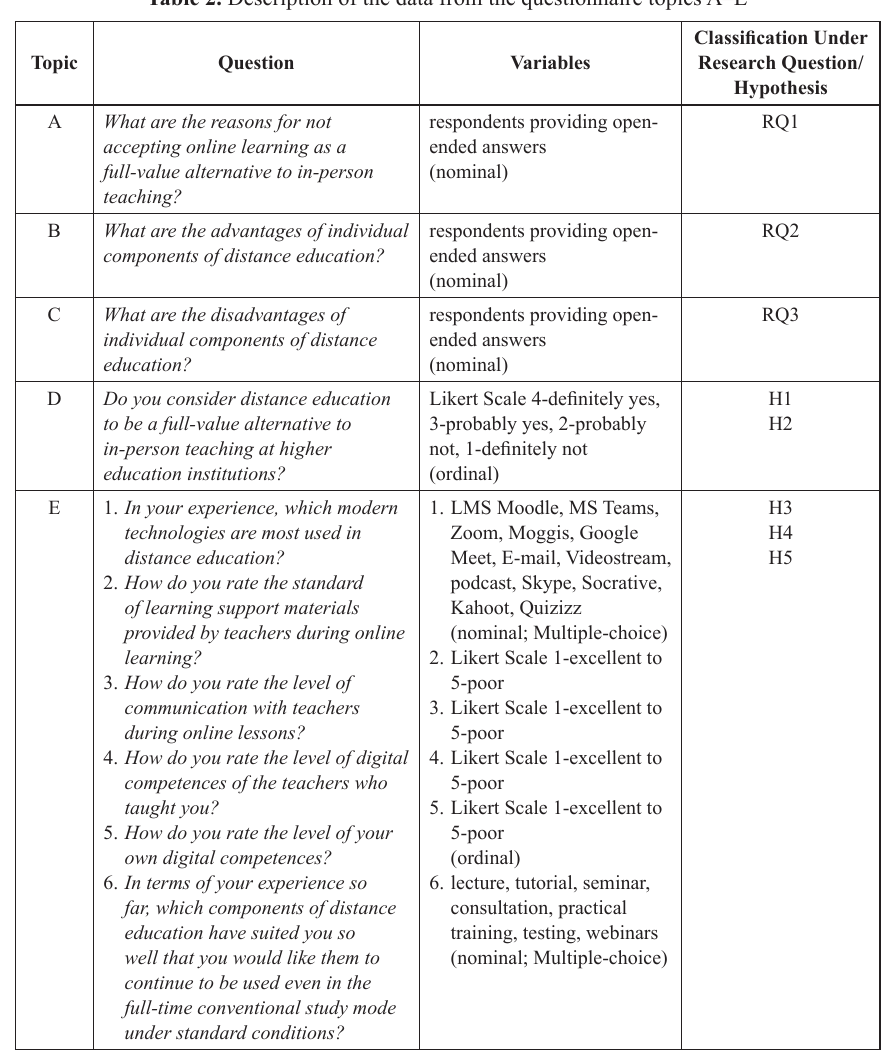
Table 2. Description of the data from the questionnaire topics